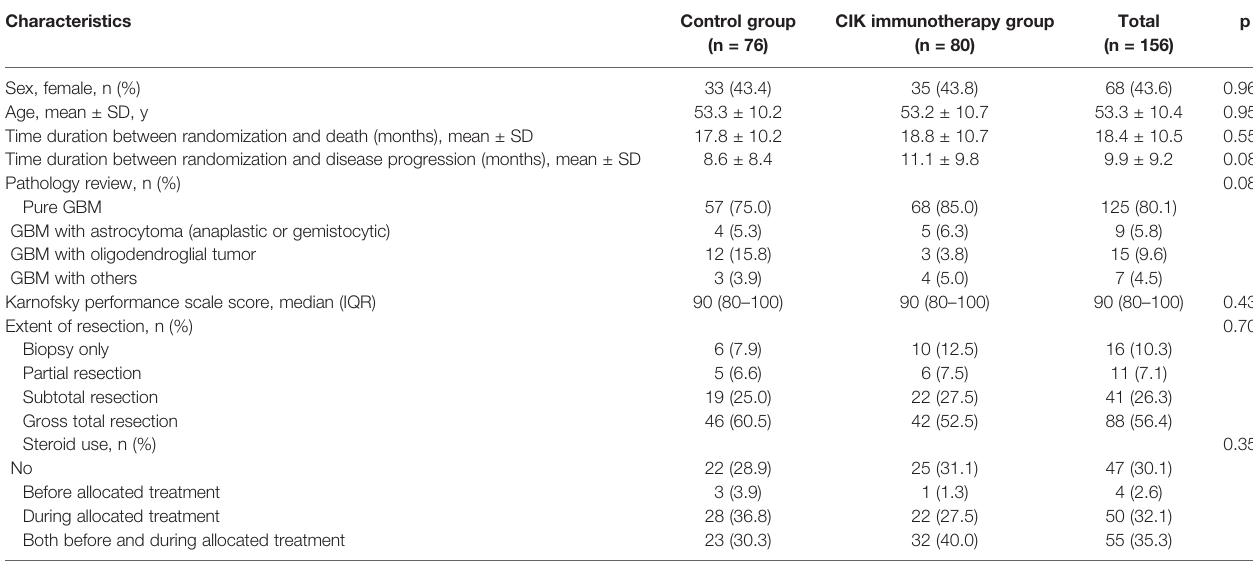
TABLE 1 | Clinical characteristics of patients with GBM in the modi fi ed ITT population.